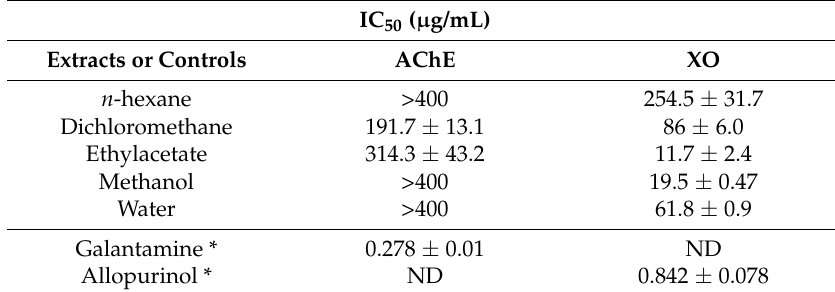
Table 2. Acetylcholinesterase (AChE) and Xanthine Oxidase (XO) inhibitory activity of the extracts from aerial parts of S. pachyphylla .